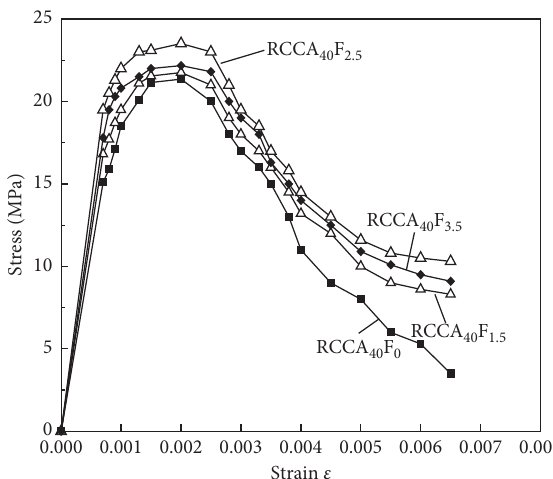
RCCA 40 F 2.5 , and RCCA 40 F 3.5